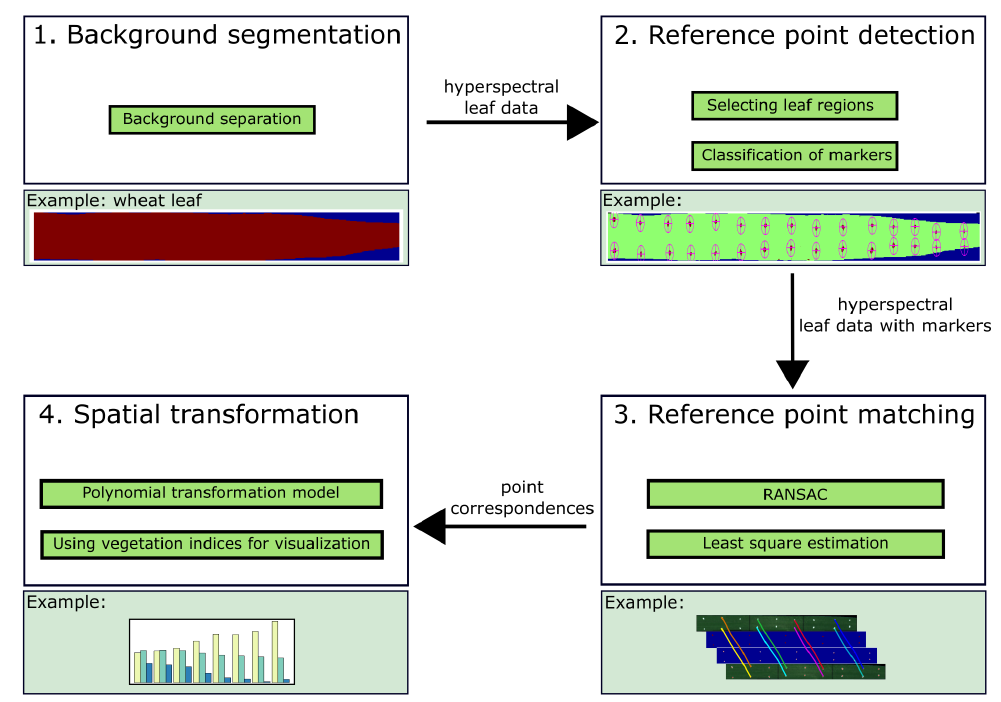
Figure 3. Dataflow of the proposed algorithm for geometric referencing of hyperspectral